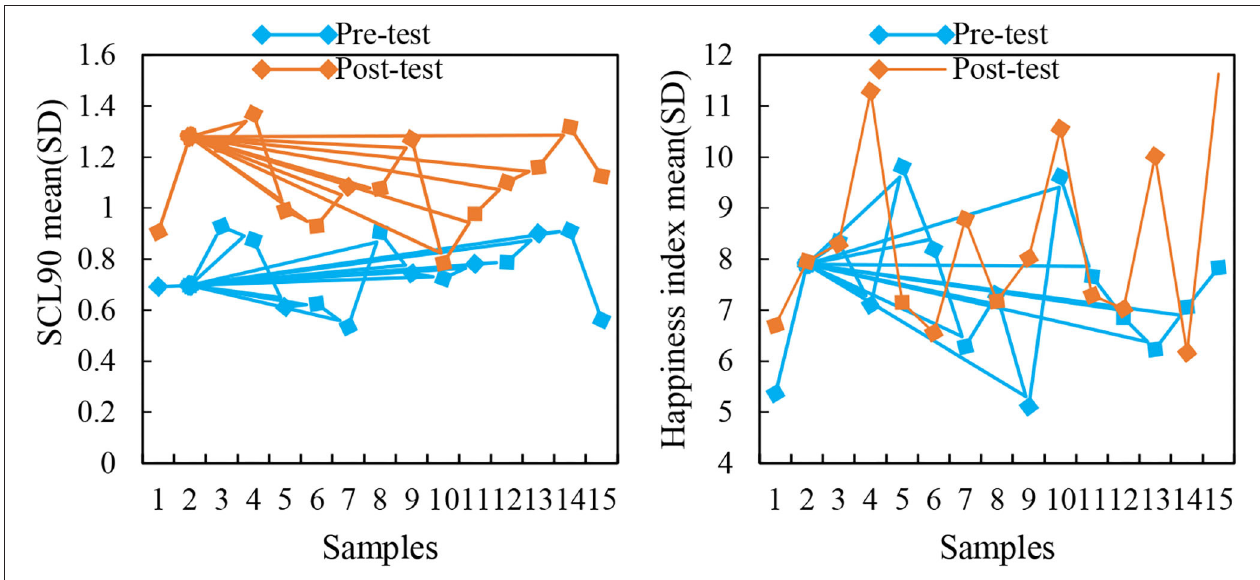
FIGURE 6 | Before and after scores of SCL90 and happiness index.